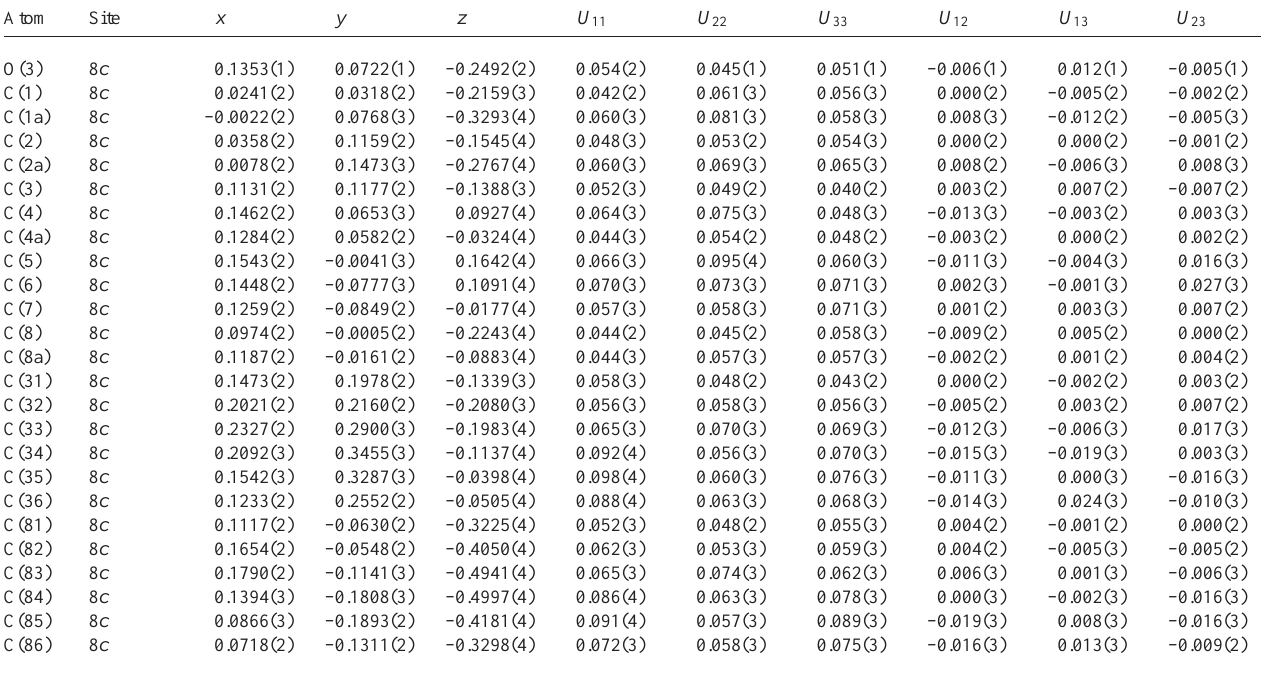
Table 3. Atomic coordinates and displacement parameters (in Å 2 )